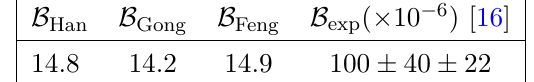
( × 10 − 6 ) . m b = 4 . 75 GeV and µ r = m Z / 2 Z → Υ(1 S +2 S +3 S )+ X